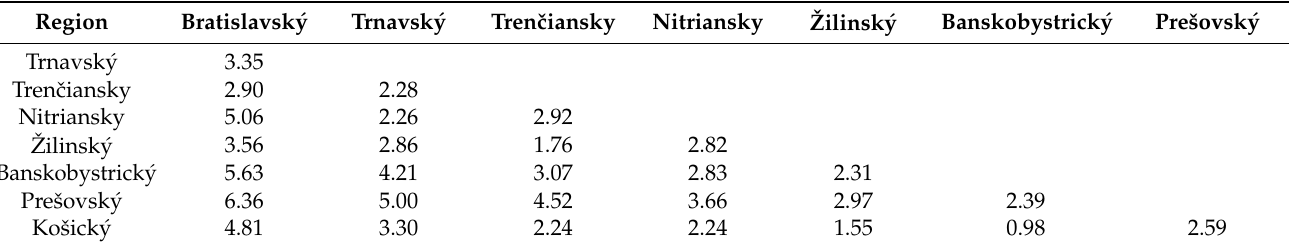
Figure 10. Communal waste development according to the net expenses of household in 2012. Table 11. Values of mutual distances